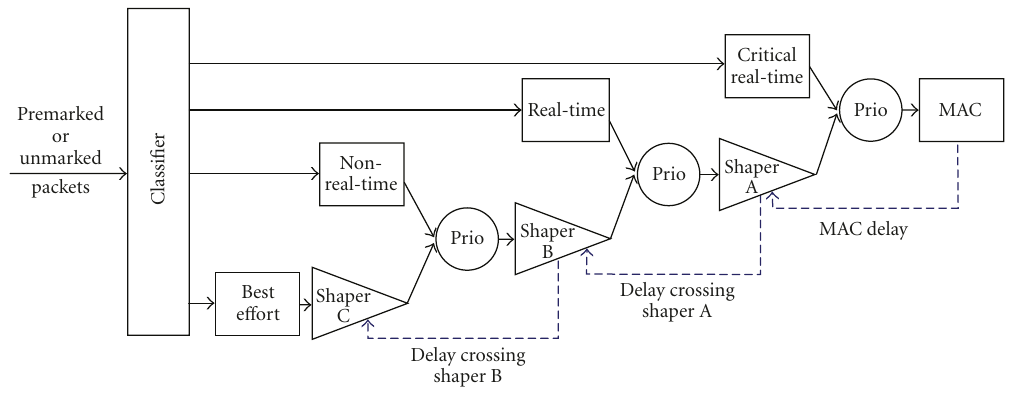
Figure 4: Di ff erentiation